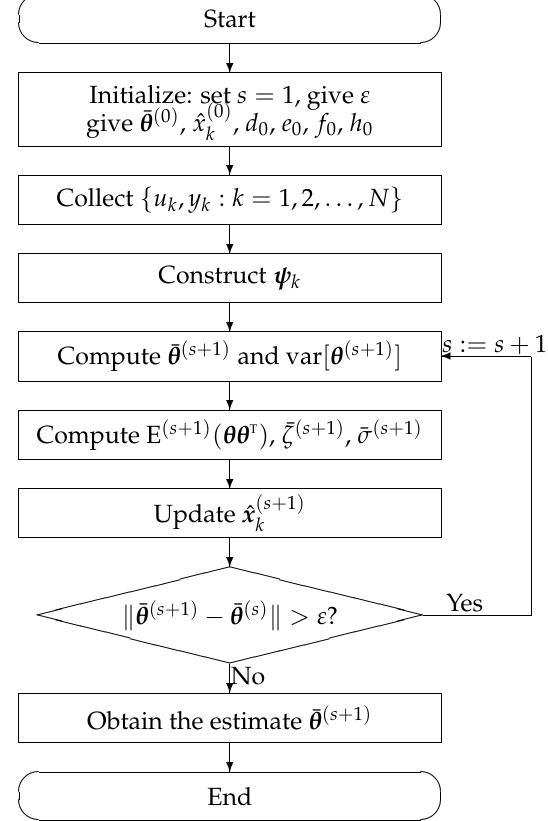
Figure 1. The flowchart of the proposed variational Bayesian Kalman filter (VB-KF) iterative algorithm for computing parameters and